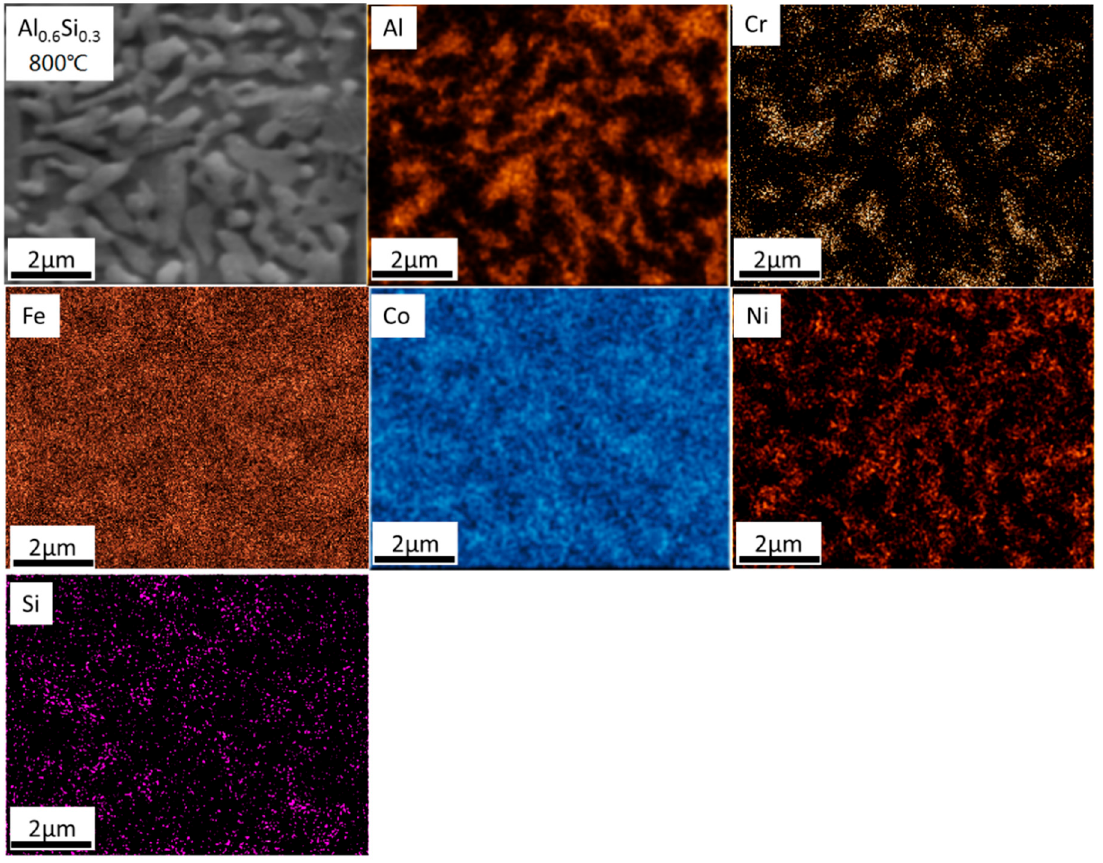
Figure 6. BSE SEM-micrographs and EDS map scan of Al 0.6 Si 0.3 after heat treatment at T = 800 °C.